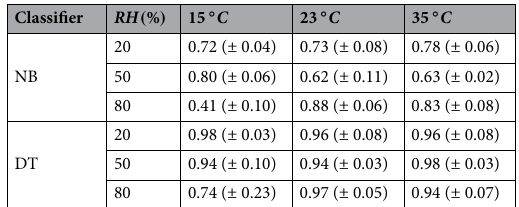
Table 2. Regime classification results on validation set under each specific RH and T condition with two different classifiers.